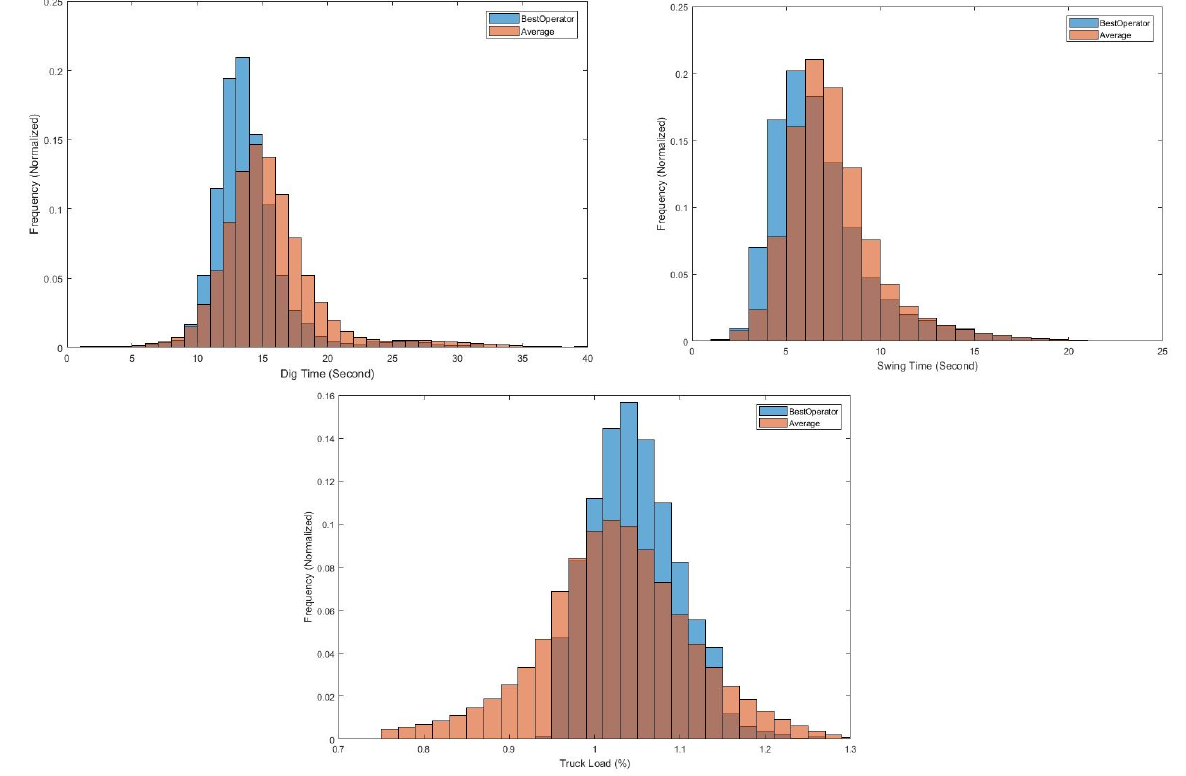
Figure 3. Best operator statistics vs. fleet